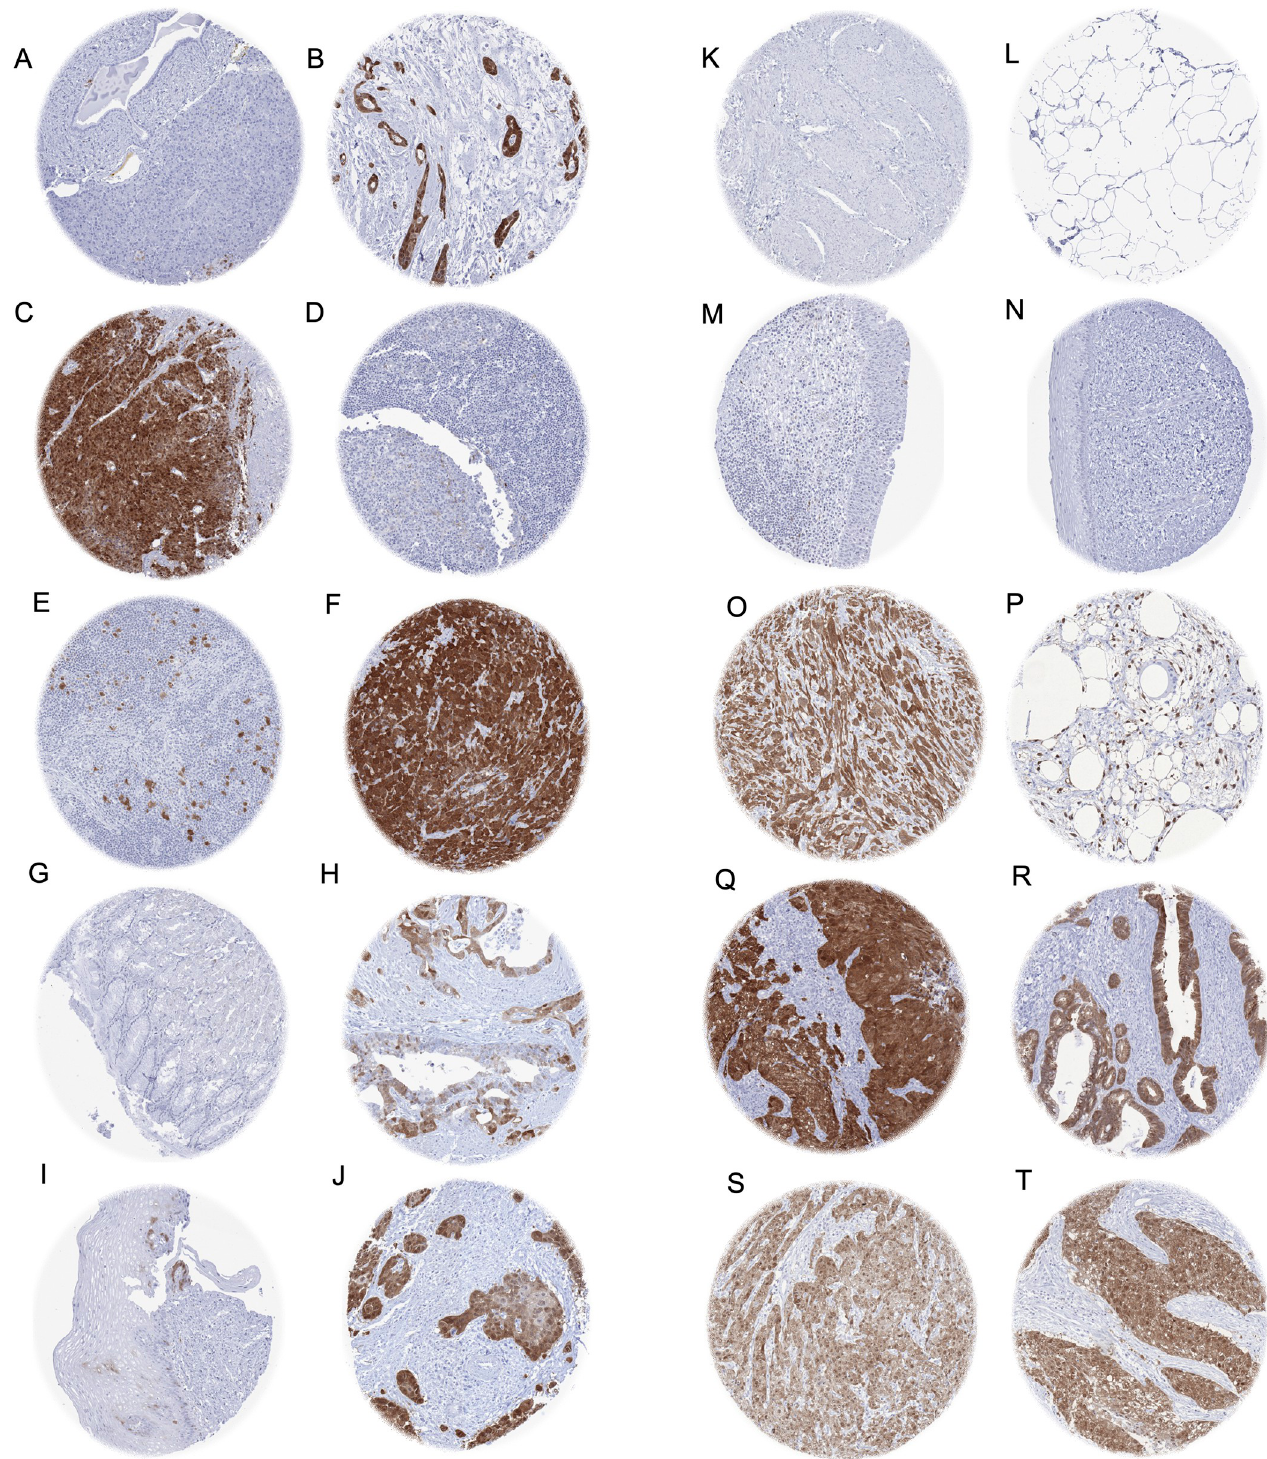
Fig 2. p16 immunostaining of tumors and related normal tissues. In the pancreas, a moderate p16 immunostaining is regularly seen in a subset of islet cells and only occasionally occurs in few scattered cells of excretory ducts (A), but p16 expression can be strong in cases of ductal adenocarcinoma (B) and of neuroendocrine carcinoma (C). In normal lymphatic tissues, a weak p16 staining occurs in germinal centre macrophages and in some scattered lymphocytes (D) but a strong staining is seen in neoplastic cells of some Hodgkin‘s (E) and diffuse large B-cell lymphomas (F). In the stomach, few normal epithelial cells